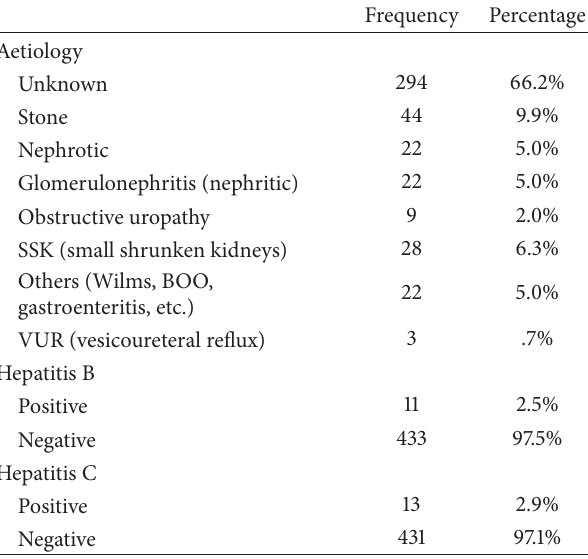
Table 2: Clinical status of ESRD